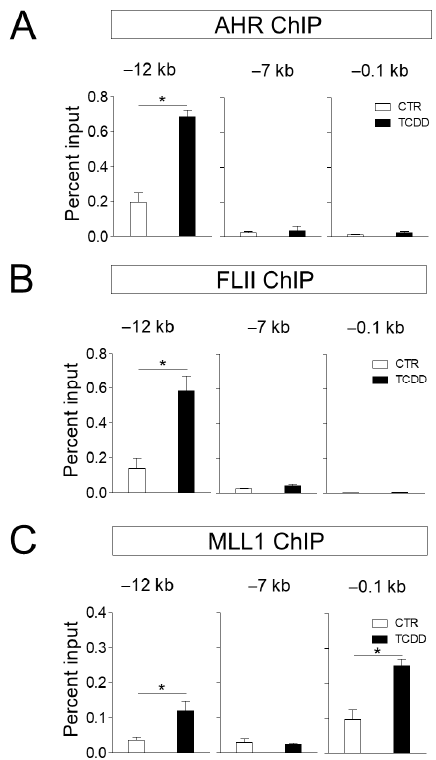
Figure 3. FLII and MLL1 are recruited to the CYP1A1 enhancer. ( A–C ) Chromatin immunoprecipitation assays were performed with ARPE-19 cells treated with 10 nM TCDD or vehicle for 20 min in 150-mm dishes. After immunoprecipitation of cross-linked chromatin fragments with the AHR, FLII or MLL1 antibody, precipitated DNA was analyzed by qPCR with primer sets of − 12 (enhancer), − 0.1 (promoter) and − 7 kb (control) from the transcription start site of the CYP1A1 gene. Data are presented as means ± S.D. (n = 3). * P < 0.05 vs control.